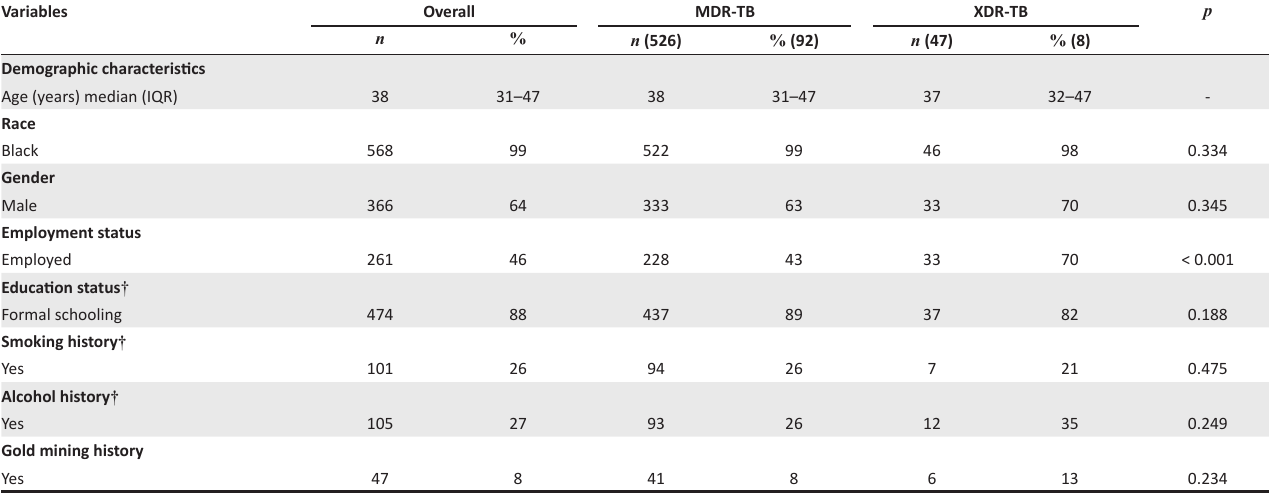
TABLE 1: Demographic characteristics of the participants. Variables